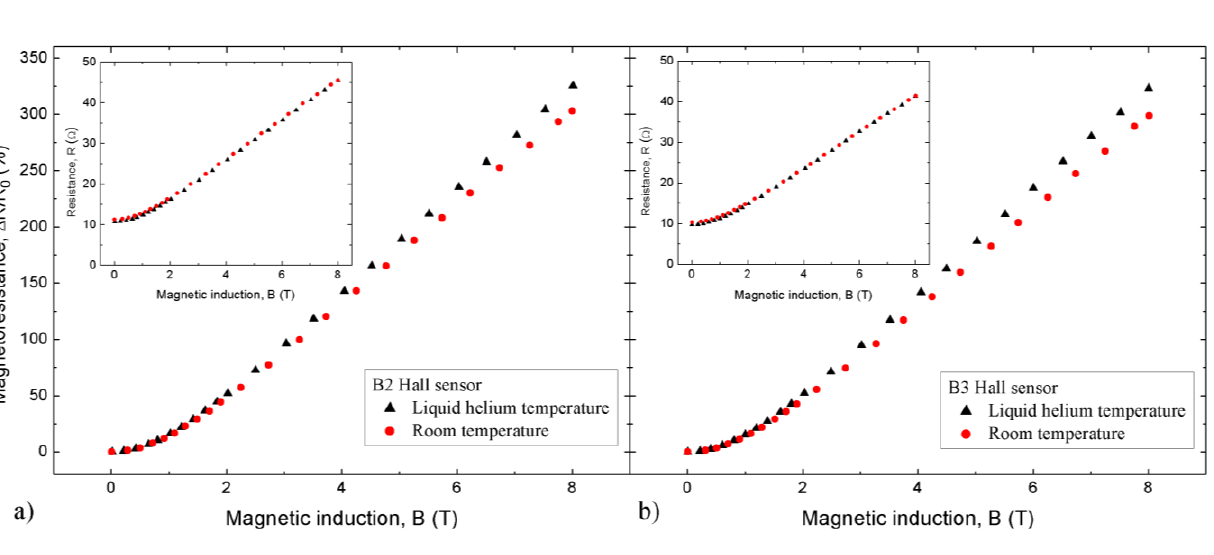
in the range (0–8) T 0